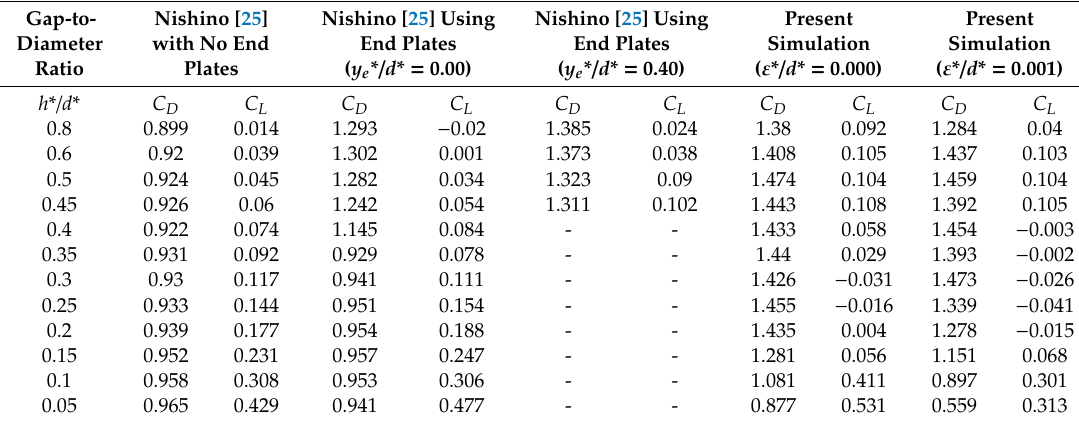
Table 1. Experimental and numerical data of aerodynamic force coe ffi cients for the circular cylinder in the vicinity of a moving wall ( Re = 1.0 × 10 5 ).